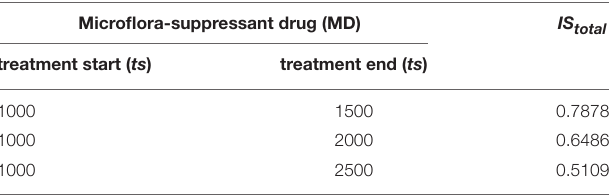
TABLE 1 | Microflora-suppressant drug treatment scenarios.